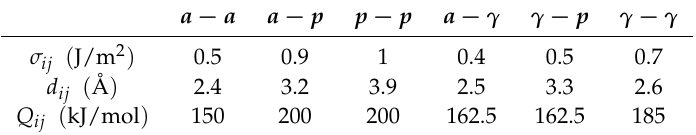
Table 2. Interfacial energy and interface mobility parameters of phase